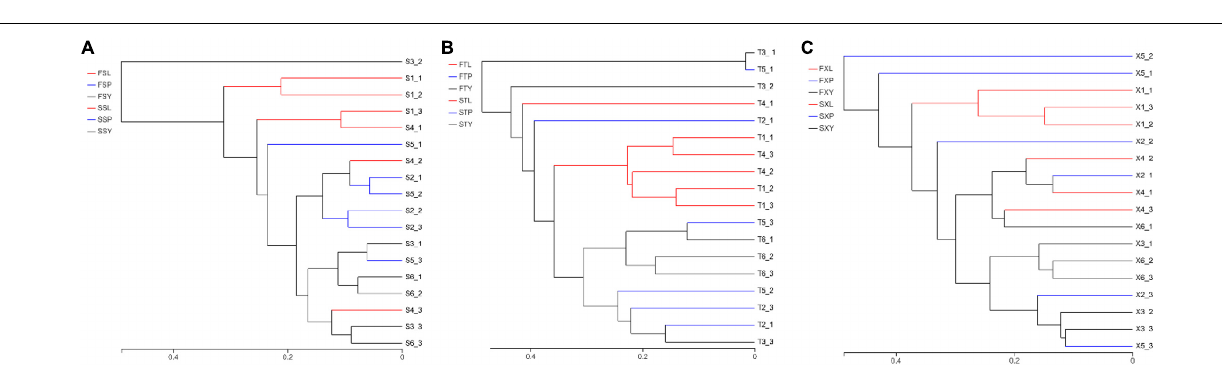
FIGURE 5 | Hierarchical clustering diagram of endophytic fungi in L. chuanxiong . (A) Refers to breeding on mountains experiment in Shuimo; (B) refers to breeding on mountains experiment in Taian; (C) refers to breeding on mountains experiment in